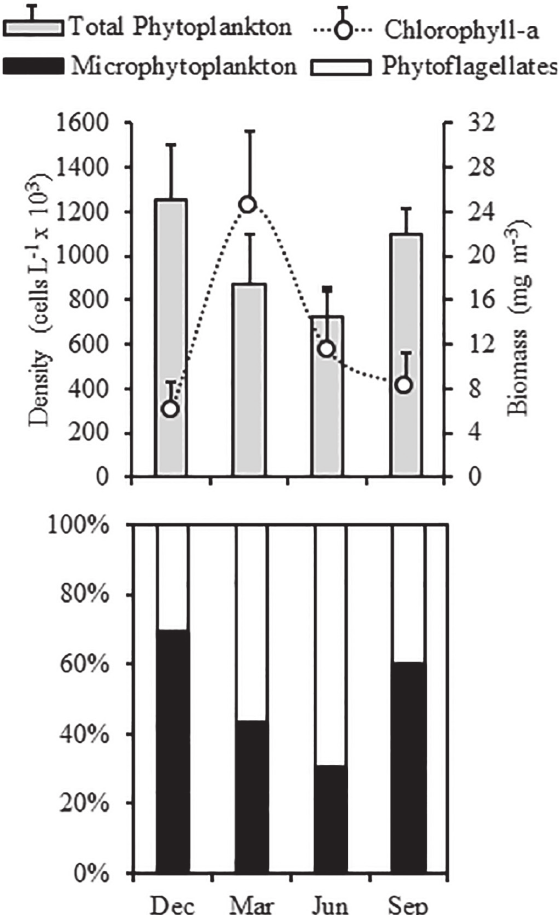
Figure 6 - Monthly average (±SD) of total phytoplankton density and biomass in terms of chlorophyll–a (A); and (B) relative abundance of Microphytoplankton and phytoflagellates at Ajuruteua beach, Bragança,